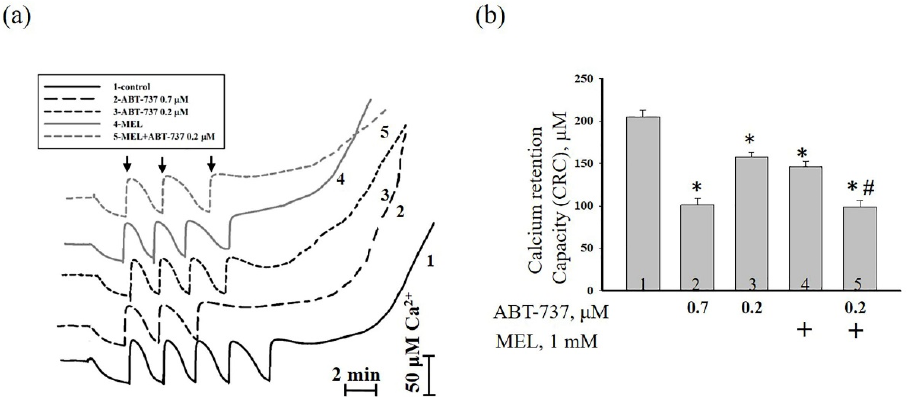
Figure 5. The effect of MEL and ABT-737 on the calcium retention capacity (CRC) in HL-60 cells. Cells were treated with 0.7 μ M ABT-737 (column 2), and 0.2 μ M ABT-737 (columns 3) and 1 mM MEL (column 4), and MEL in combination with 0.2 μ M ABT-737 (column 5); untreated cells (control, column 1). ( a ) Ca 2+ fluxes in HL-60 cells permeabilized with digitonin (0.007%). Arrows show the times at which CaCl 2 (50 nmol of Ca 2+ per mg of protein) was added; ( b ) Quantitative analysis of Ca 2+ retention capacity corresponding to the threshold concentration of Ca 2+ . “+” means the presence of MEL The data are presented as the means ± S.D. of five separate experiments. * p < 0.05 significant difference relative to the control (untreated cells), # p < 0.05 significant difference compared to MEL alone (column 4).